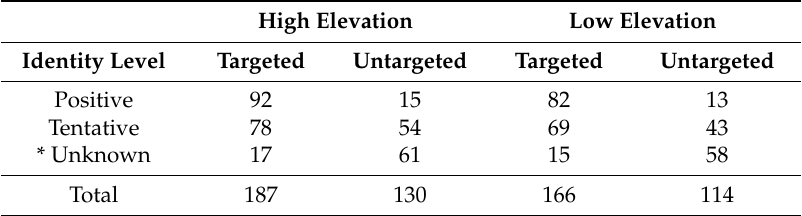
Figure 2. The TIC (a) and RIC chromatograms of targeted (b, in environmental tea) and untargeted Figure 2. The TIC ( a ) and RIC chromatograms of targeted ( b , in environmental tea) and untargeted (c, due to farmer processing) compounds in high elevation pu-erh tea. ( c , due to farmer processing) compounds in high elevation pu-erh tea. Table 1. Targeted and untargeted compounds found by Ion Table 1. Targeted and untargeted compounds found by Ion Analytics.